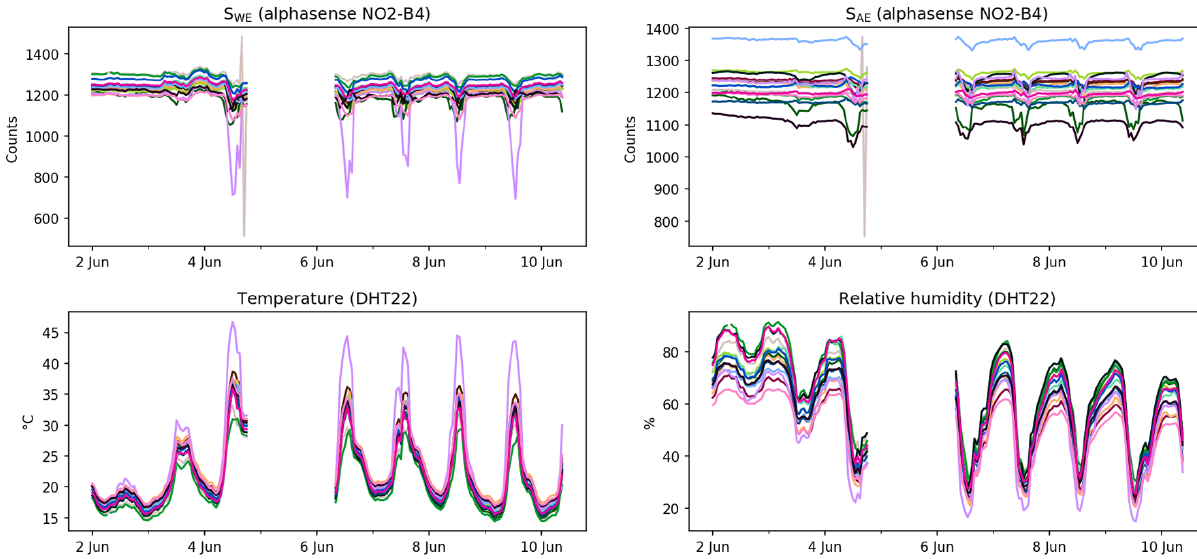
Figure 3. Raw sensor data, unfiltered but hourly averaged, from the 16 sensors during the first calibration period, 2–10 June 2016. The data gap around 5 June is due to a connectivity problem to the central